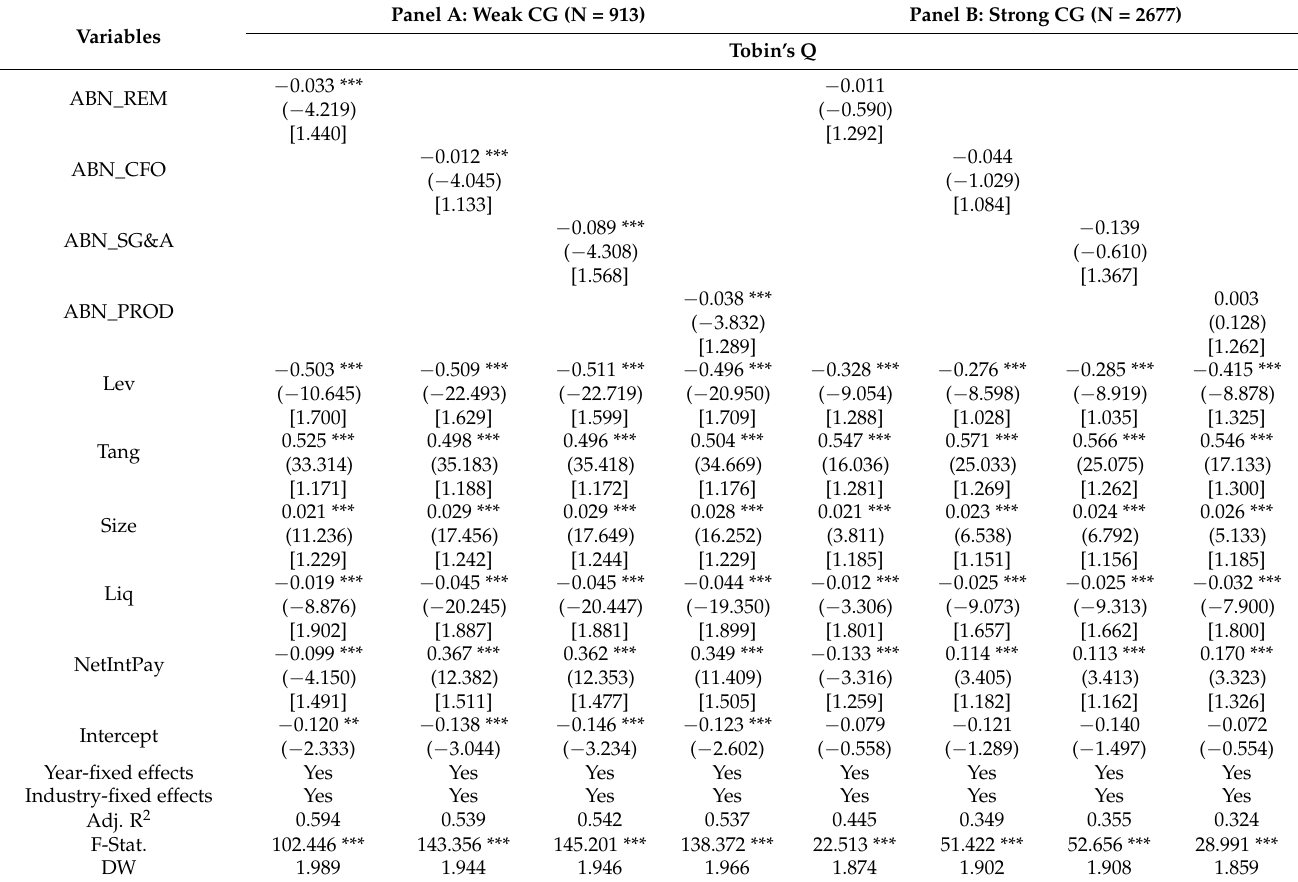
Table 8. Relationship between FV and REM for firms with strong and weak